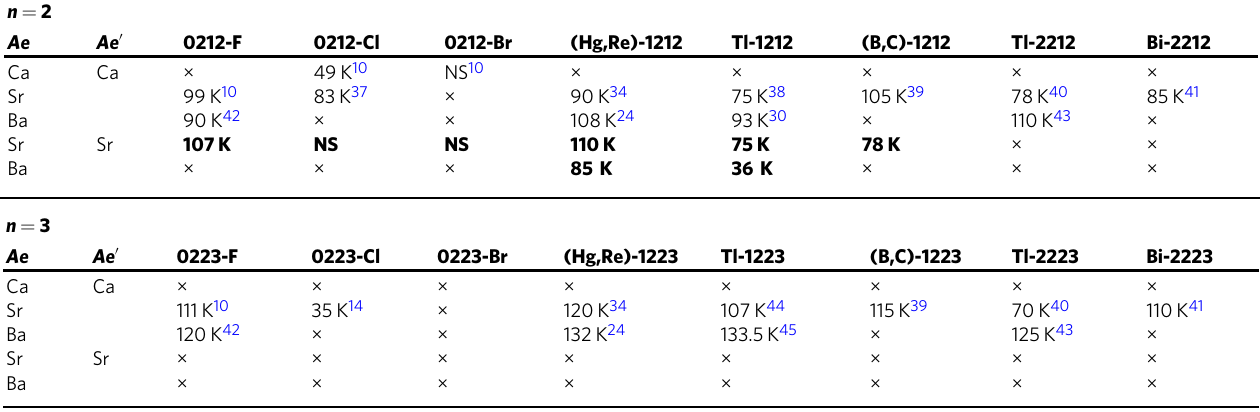
Table 1 Phase availability of various multilayered cuprates with the chemical formulas of Ae Ae Ae 0 and M n (cid:2) 1 Cu n O 2 n + 4 2 2